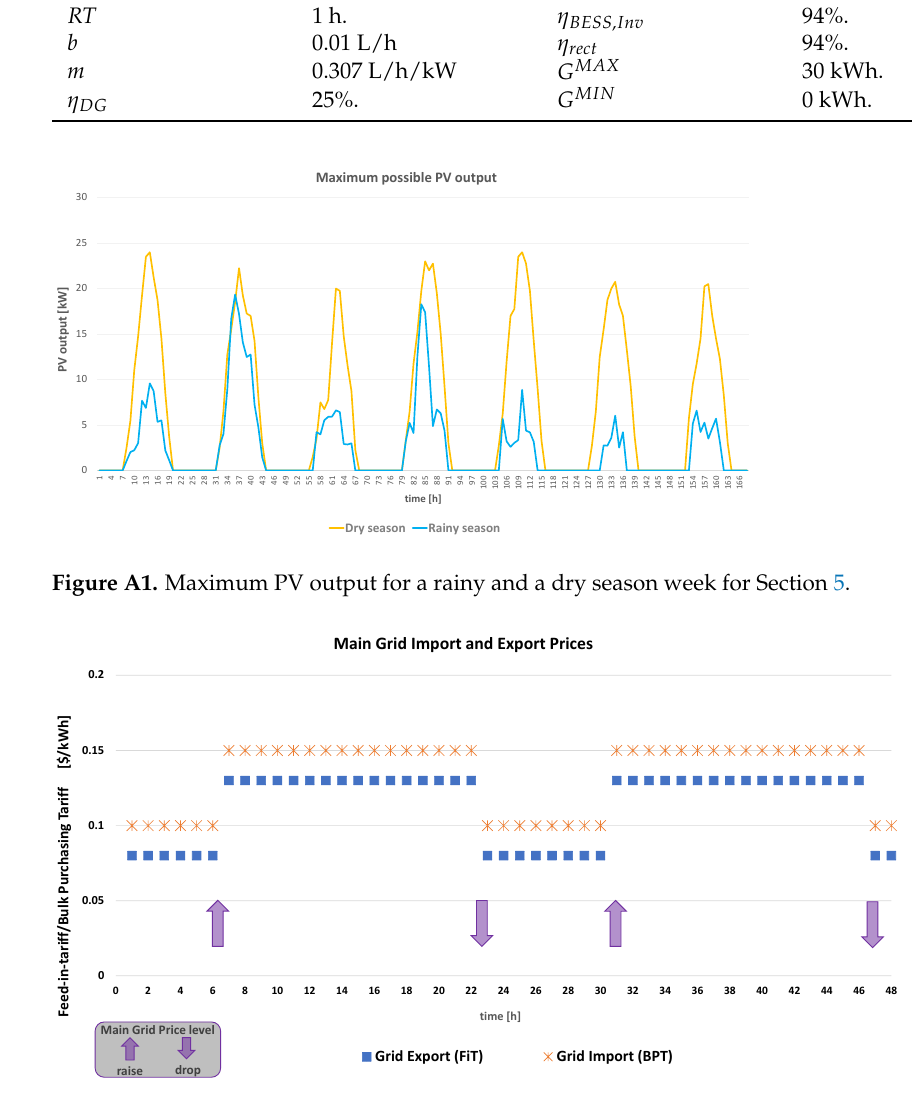
Figure A2. Data Input for FiT and BPT for Section